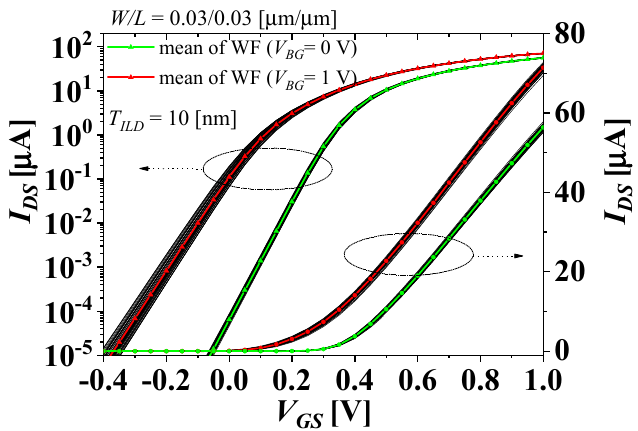
Figure 4. I ds - V gs characteristics of the top-tier NMOS considering the WFV of both the top- and bottom-tier gates.